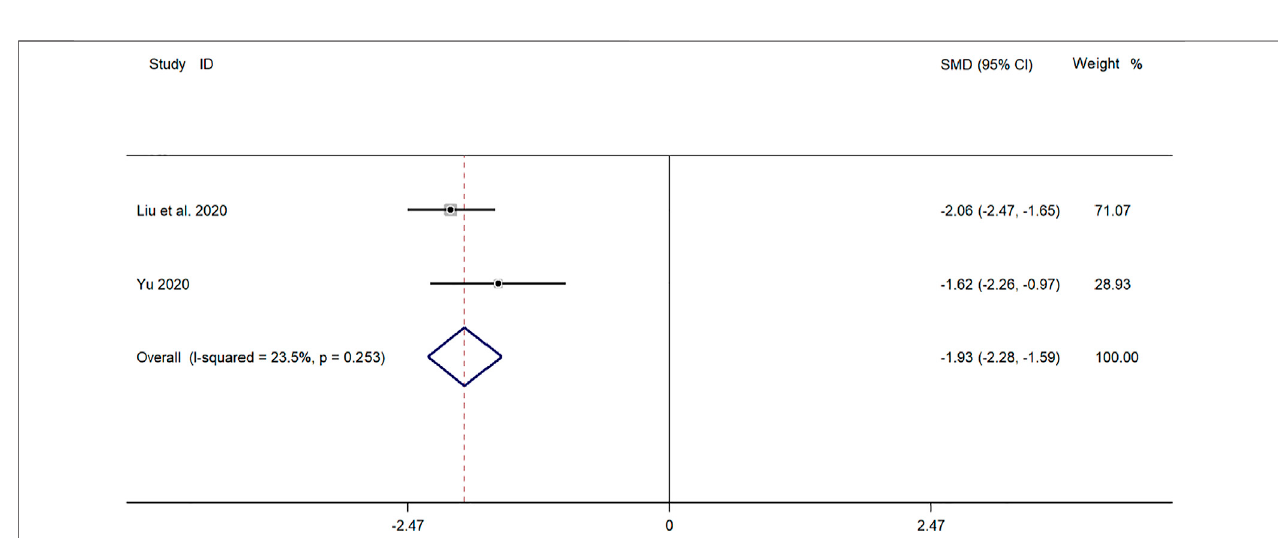
FIGURE 7 | Meta-analysis of forest plots comparing the time for return to normal of chest X-ray in the experimental and control group.